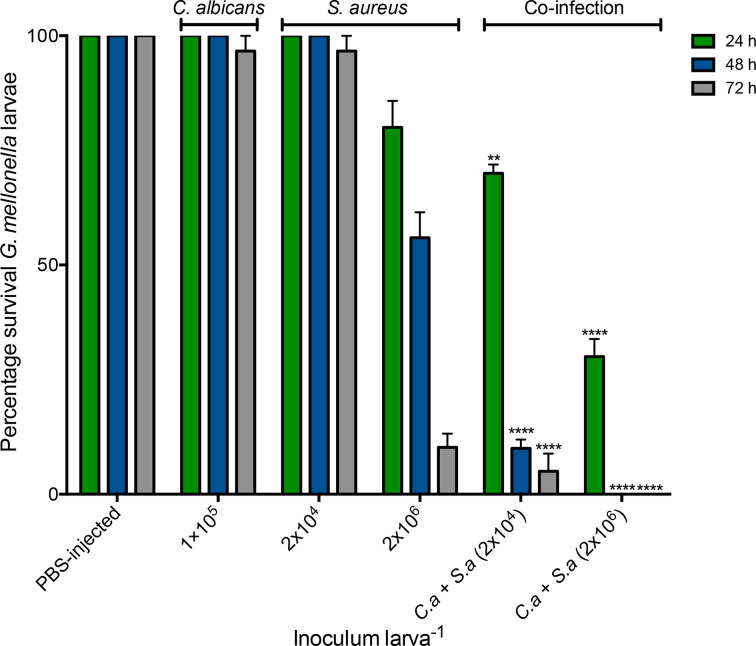
Survival of G. mellonella larvae following mono- and co- infection with C. albicans and 
S. aureus
. Larvae were infected with 20 µl of C. albicans or 
S. aureus
 or co-infected (1×105
C. albicans with varying concentrations of 
S. aureus
) and survival was assessed over 72 h at 37 °C. Statistical significance was determined by comparing co-infected larvae to the relevant 
S. aureus
 mono-infected larvae (**, P<0.01; ****, P<0.0001). Larvae were also injected with 20 µl PBS (PBS-injected). All values are the mean±se of three independent experiments.